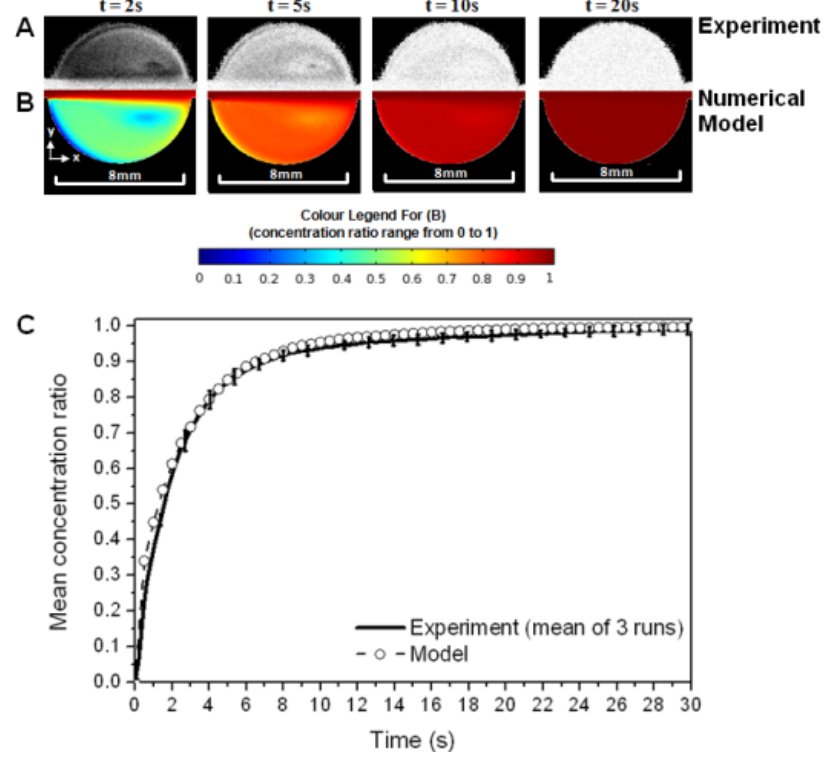
Figure 4. Performance of the circular flow cell when the flow rate was 10 mL/min: ( A ) processed experimental images, where black is low concentration and white is high concentration, ( B ) predicted concentration maps, and ( C ) Mean concentration ratio within the flow cell as a function of